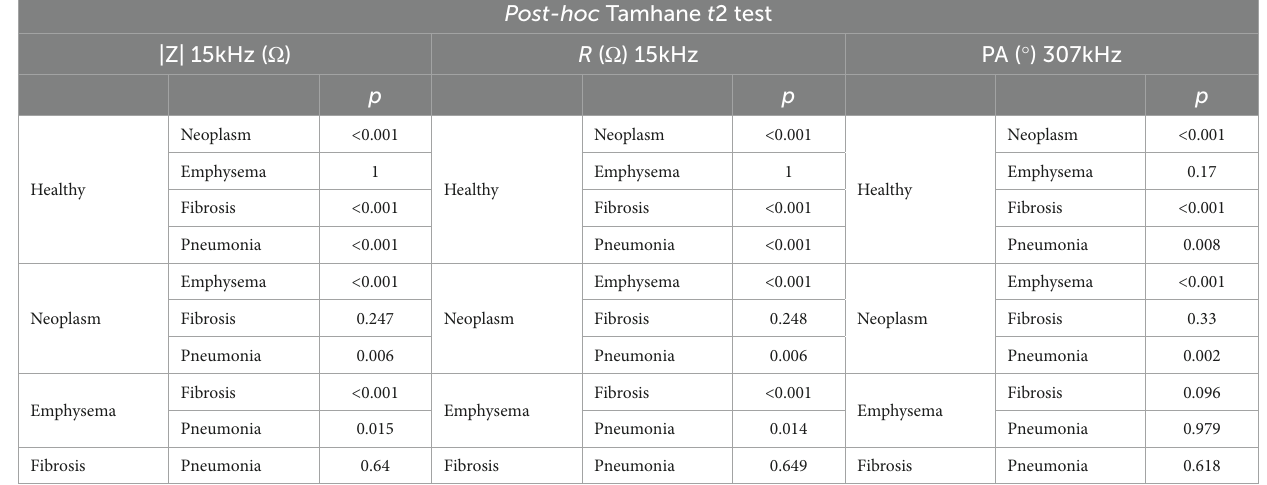
TABLE 2 Tamhane t 2 post-hoc test results for |Z| at 15 kHz, PA at 307 kHz and R at 15 kHz.